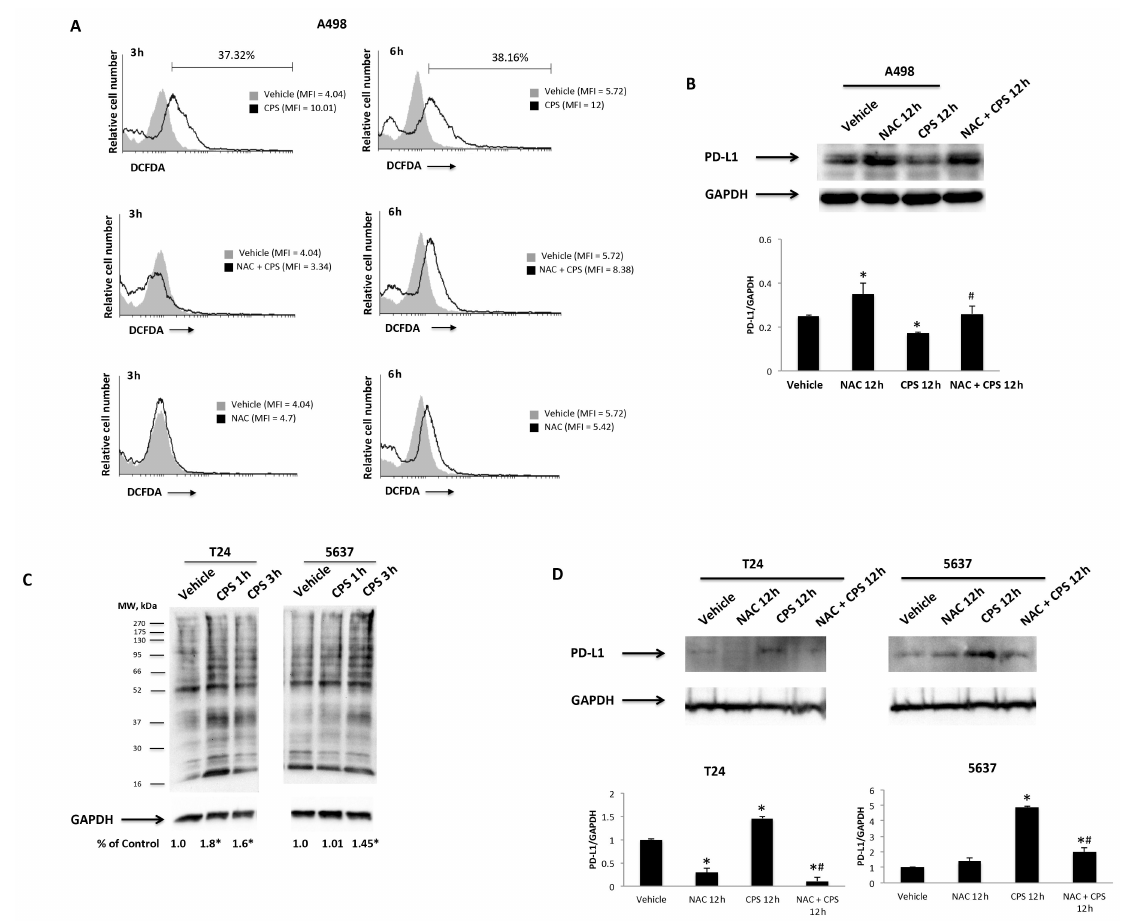
Figure 6. CPS influences PD-L1 protein levels via ROS production. ( A ) ROS generation in A498 cells pretreated with NAC for 1 h and then treated with 50 µ M CPS for up to 24 h. Cells were stained with DCFDA before flow cytometric analysis. MFI = mean fluorescence intensity. ( B ) Immunoblot representative of PD-L1 expression in A498 cells pretreated with NAC and then stimulated with CPS for 12 h. PD-L1 densitometry values were normalized to GAPDH, used as the loading control. Data are expressed as the mean ± SD; * p < 0.05 vs. vehicle-treated cells, # p < 0.05 vs. CPS treated cells. ( C ) Carbonyl groups generated by oxidative stress were subjected to DNPH derivatization, and increases in oxidatively modified proteins were detected with an antibody against DNP after size fractionation followed by Western blotting. Quantification of total protein carbonylation was performed, normalizing the densitometry values to GAPDH, used as the loading control. The image is representative of three independent experiments; * p < 0.01 vs. vehicle-treated cells. ( D ) Immunoblot representative of PD-L1 expression in T24 and 5637 cells pretreated with NAC and then stimulated with CPS for 12 h. PD-L1 densitometry values were normalized to GAPDH, used as the loading control. Data are expressed as the mean ± SD; * p < 0.05 vs. vehicle-treated cells, # p < 0.05 vs. CPS treated cells. Detailed information about the Western blotting can be found in Figure